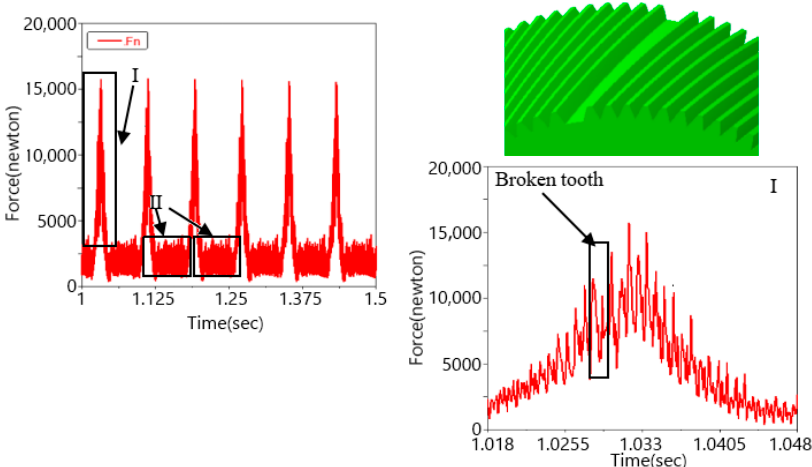
Figure 10. Schematic diagram of full broken tooth and normal meshing force with its zoom magnified image of position I.